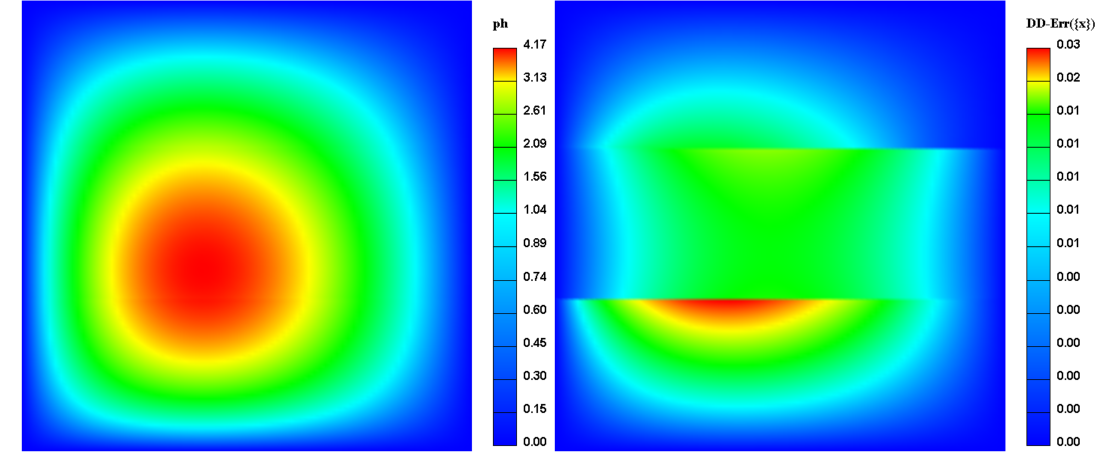
Figure 15. DN solution to problem (25) with pressure field (27) ( left ) and its error ( right